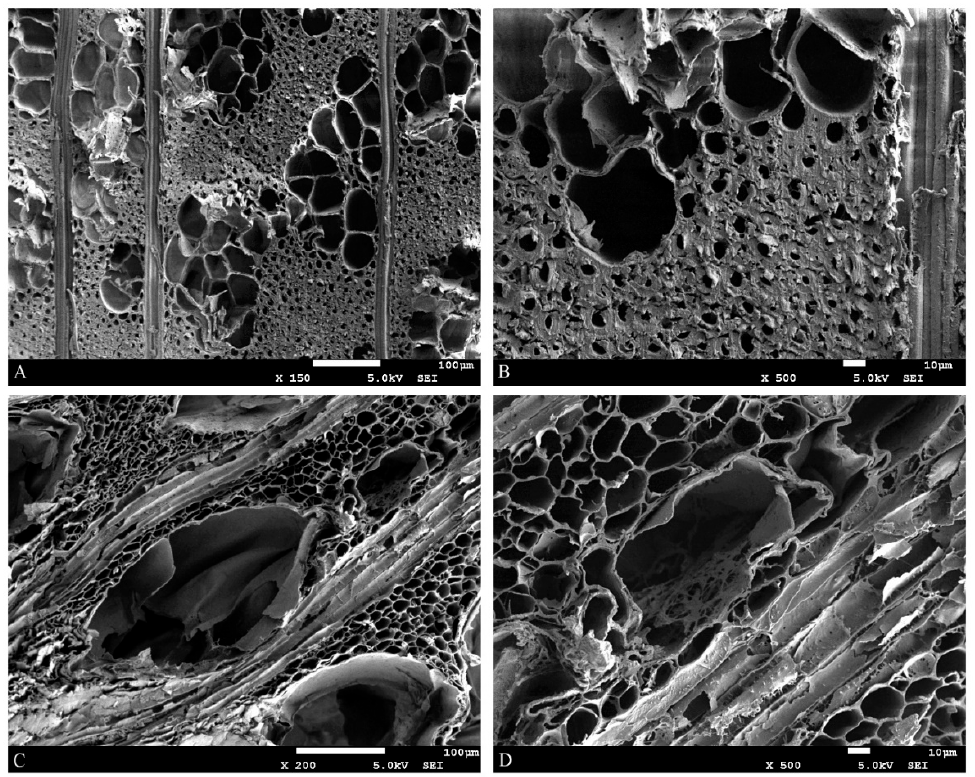
Figure 4. SEM images of air-dried elm samples: ( A , B )—contemporary wood; ( C , D )—archaeological